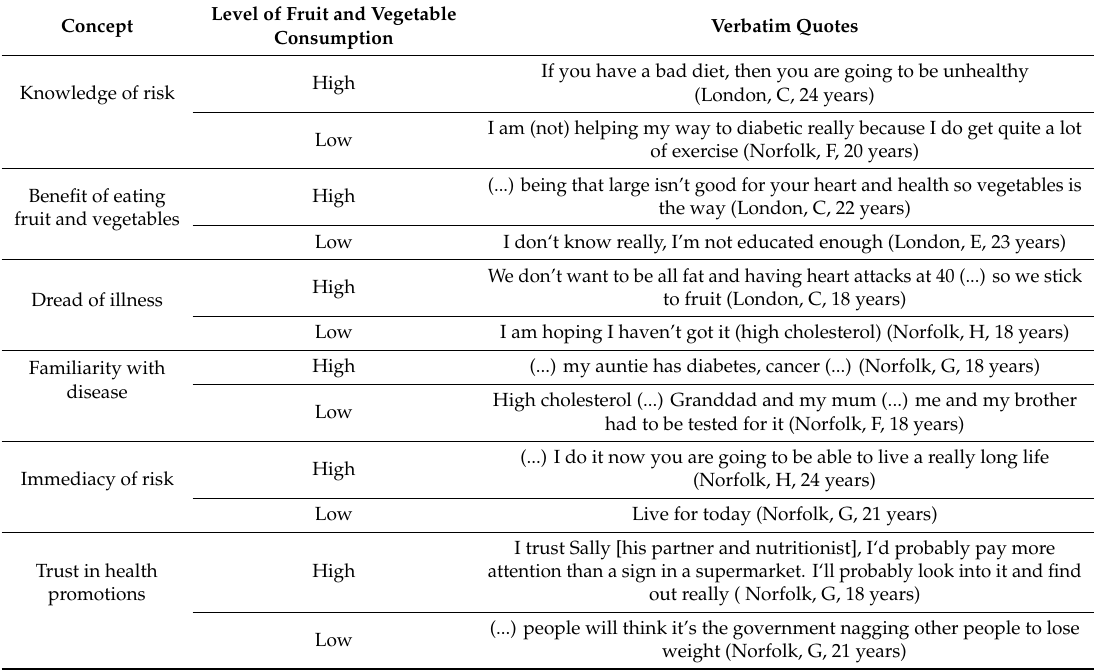
Table 5. Risk theory characteristics by high and low consumers of fruit and